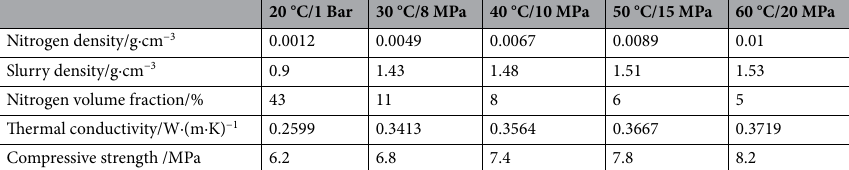
Table 4. Cement performances under different